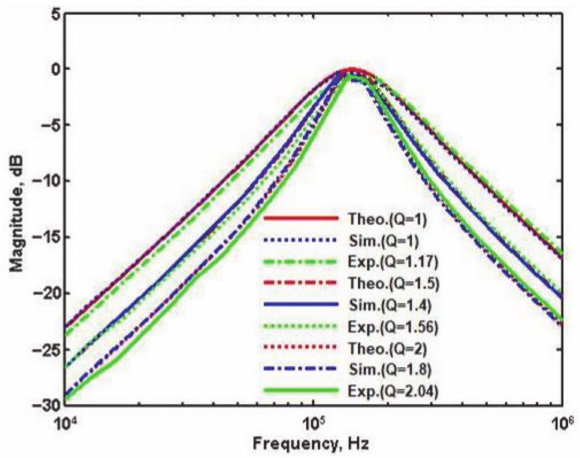
Figure 15. Gain characteristics of the BPF with different